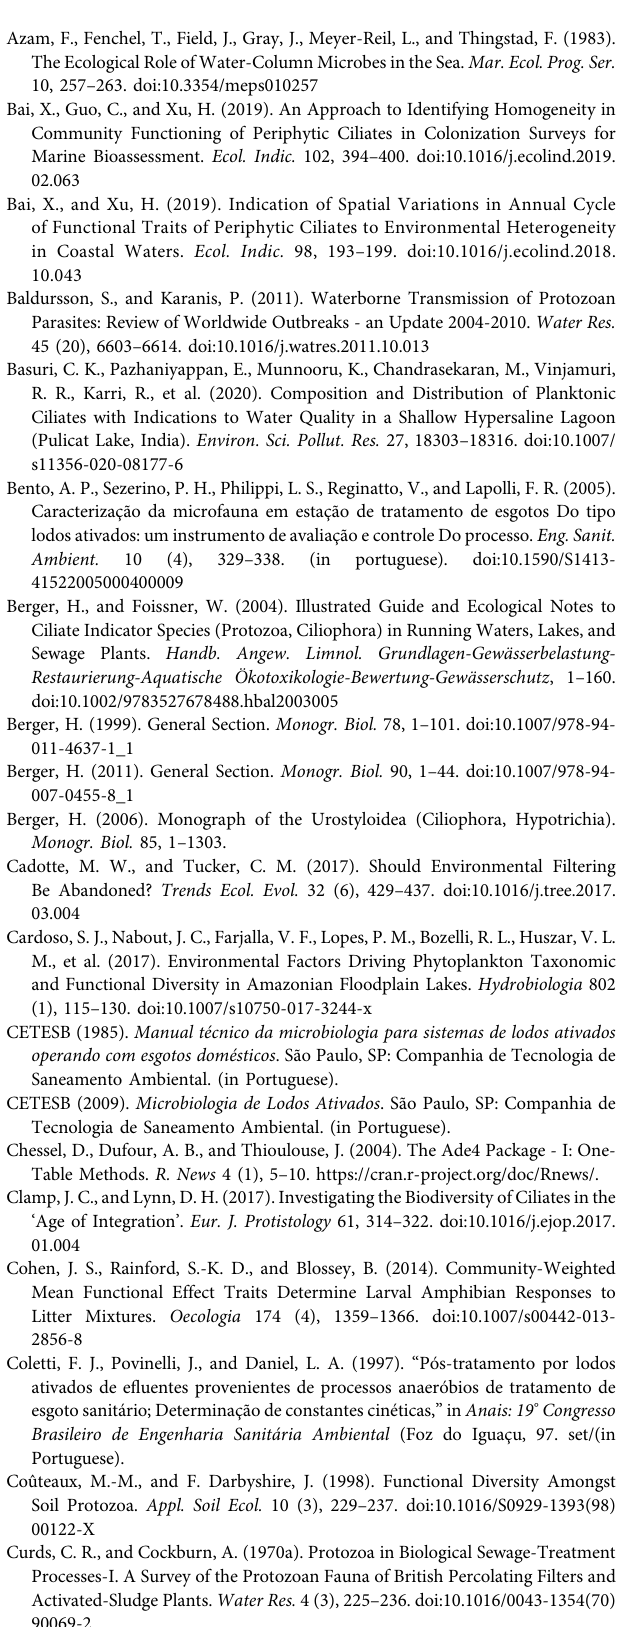
Table Methods. R. News 4 (1), 5 – 10. https://cran.r-project.org/doc/Rnews/.